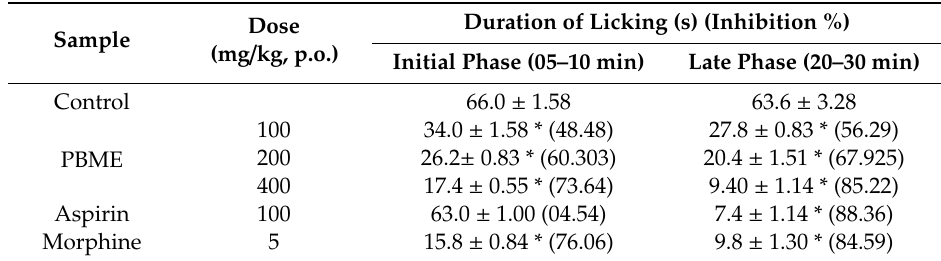
Table 3. Result of P. benghalensis leaves’ extracts on the formalin